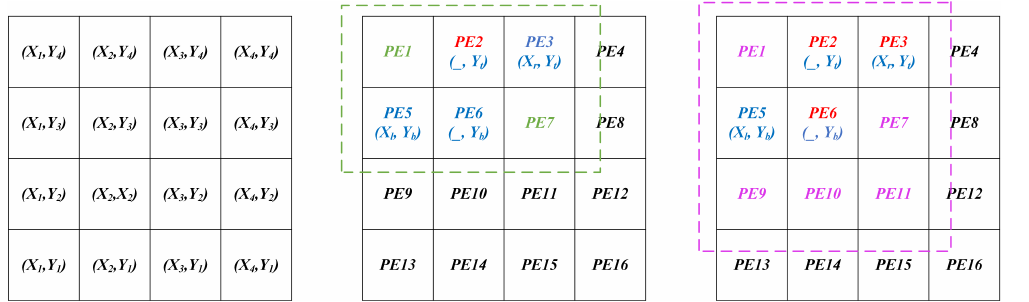
Figure 3. Proposed structure for protection of FPGA against HTs.